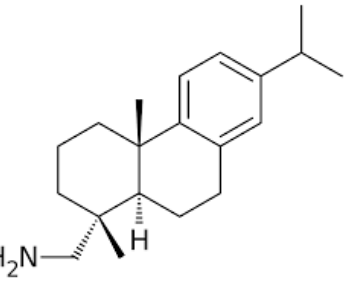
Figure 1. The chemical structure of leelamine.